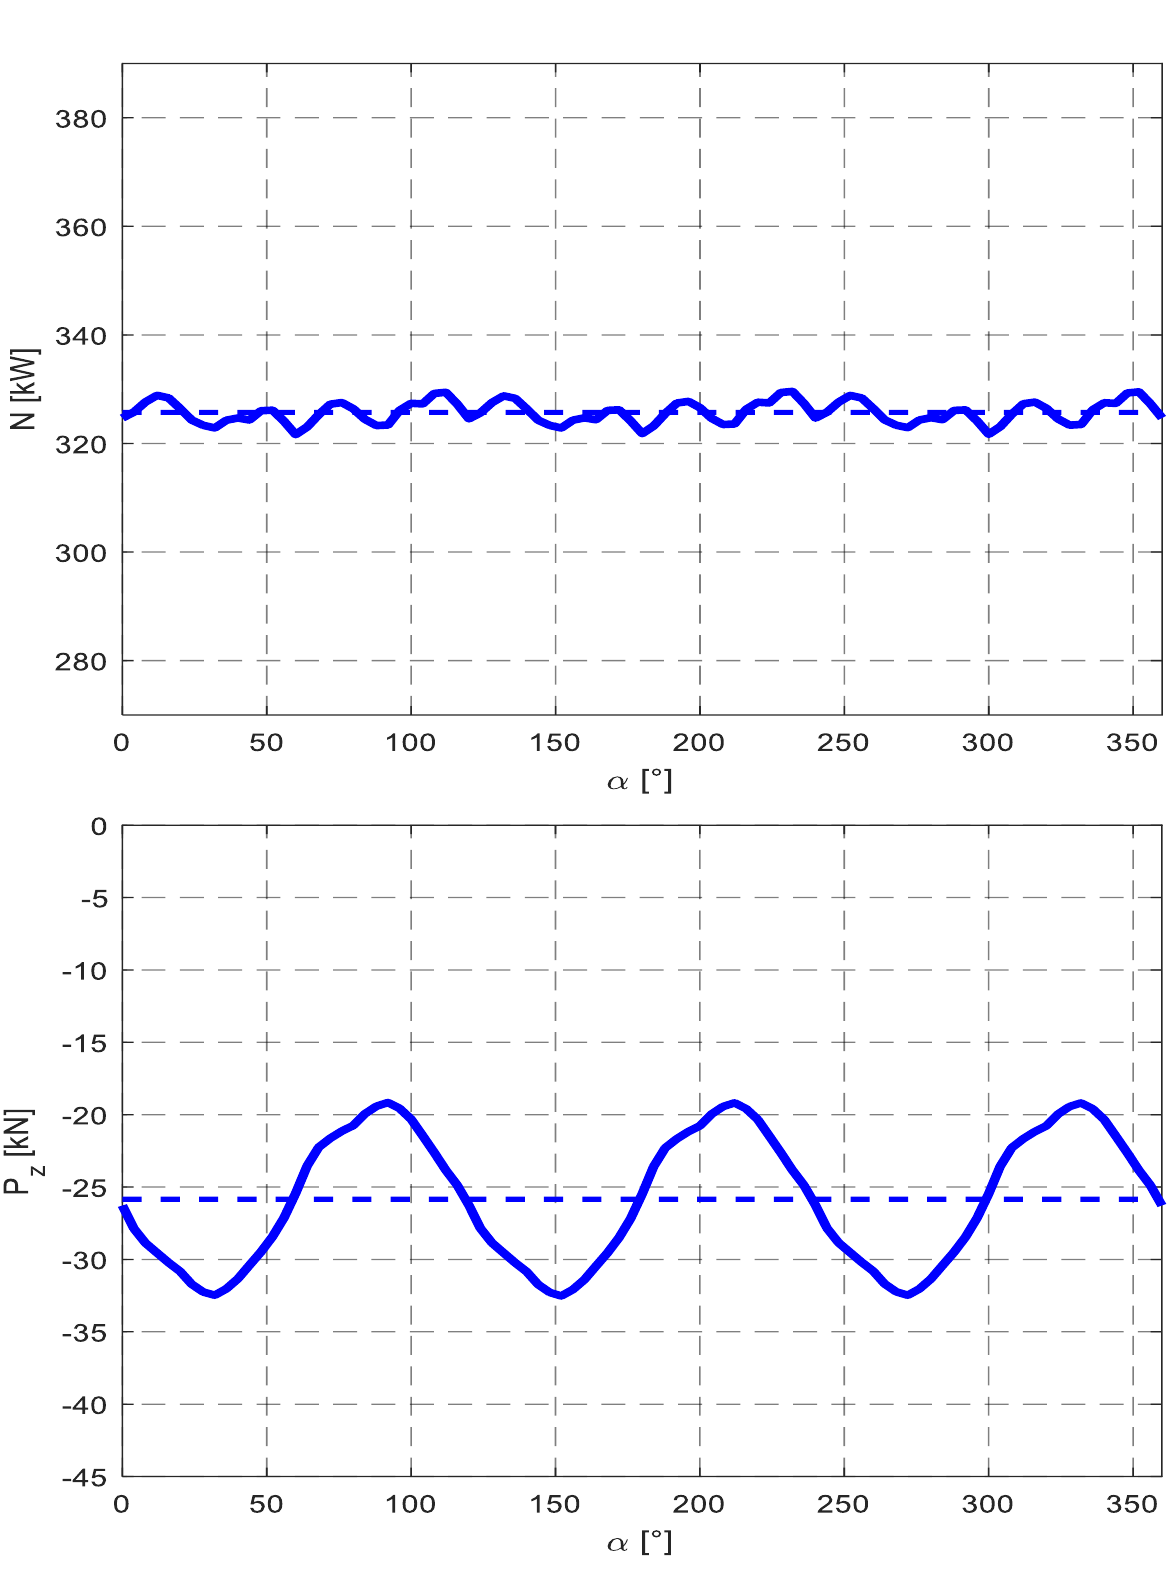
Figure 14. Waveform of the values of power N and cutting head impact force in the direction of shearer’s advance P z for pick arrangement 1b.